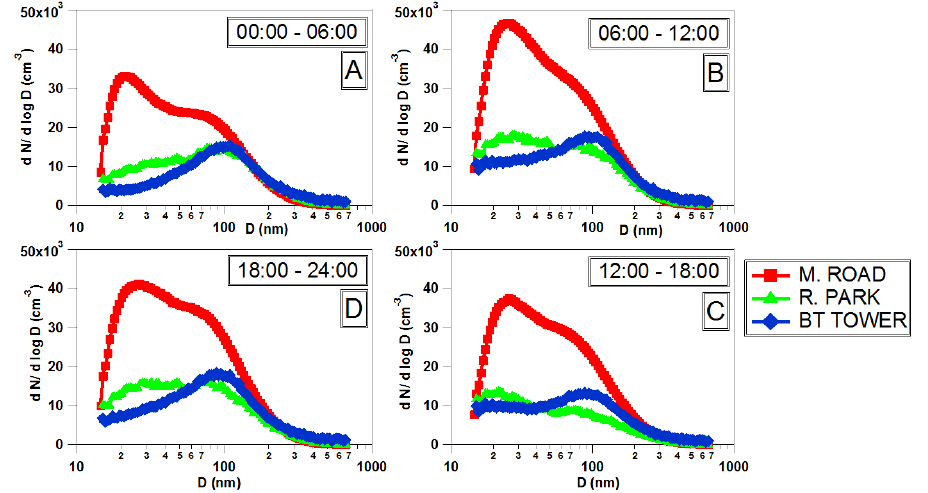
Fig. 5. Average SMPS size distributions for 3 different sites (M. Road, R. Park and BT Tower) taken simultaneously during the REPARTEE-II field study. Data are average for the 6 hours time period at 00:00–06:00 (A) , 06:00–12:00 (B) , 12:00–18:00 (C) and 18:00–24:00 (D)